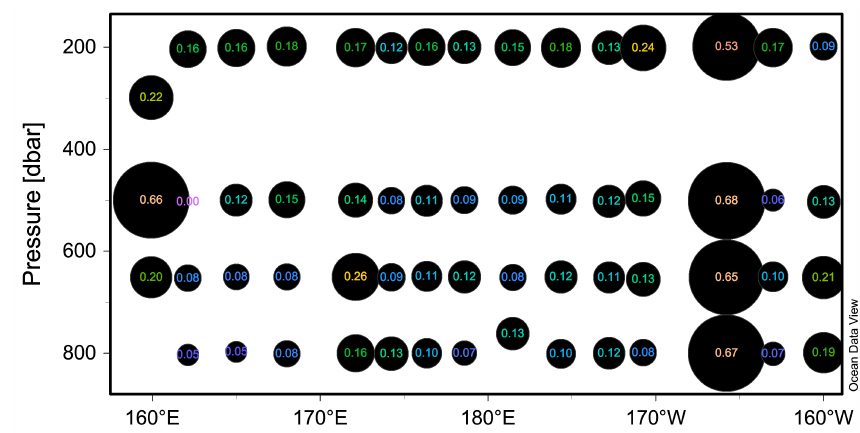
Figure 1. Longitudinal section of N 2 fixation (nmolNL − 1 d − 1 ) rates displayed as numbers overlying sized circles. For reference, the station numbers are displayed on top of the